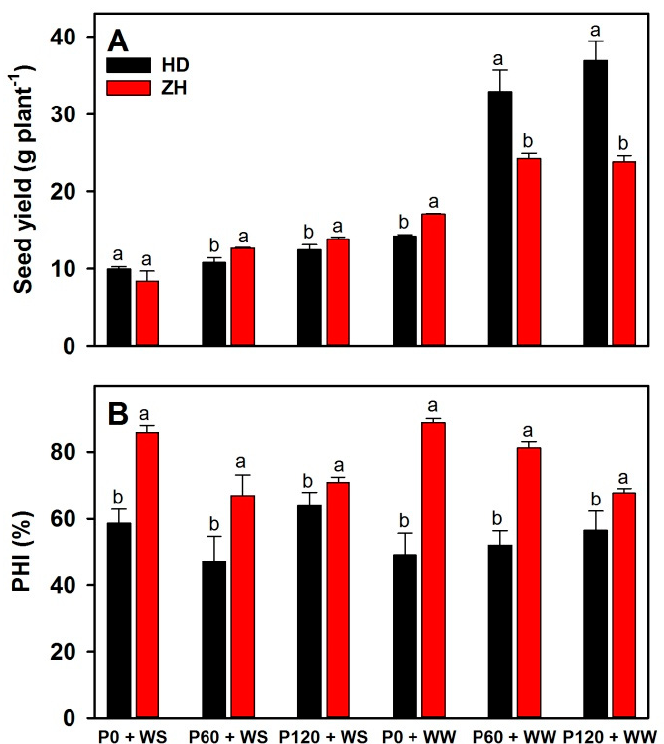
Figure 1. The ( A ) grain yield and ( B ) phosphorus harvest index (PHI) of two cultivars (Huangsedadou (HD) and Zhonghuang 30 (ZH)) under two water regimes (well-watered (WW) and cyclic water stress (WS)) and three P rates (0 (P0), 60 (P60), and 120 (P120) mg P kg –1 dry soil). Means ( ± SE) with different letters in the same panel are significantly different at p = 0.05.